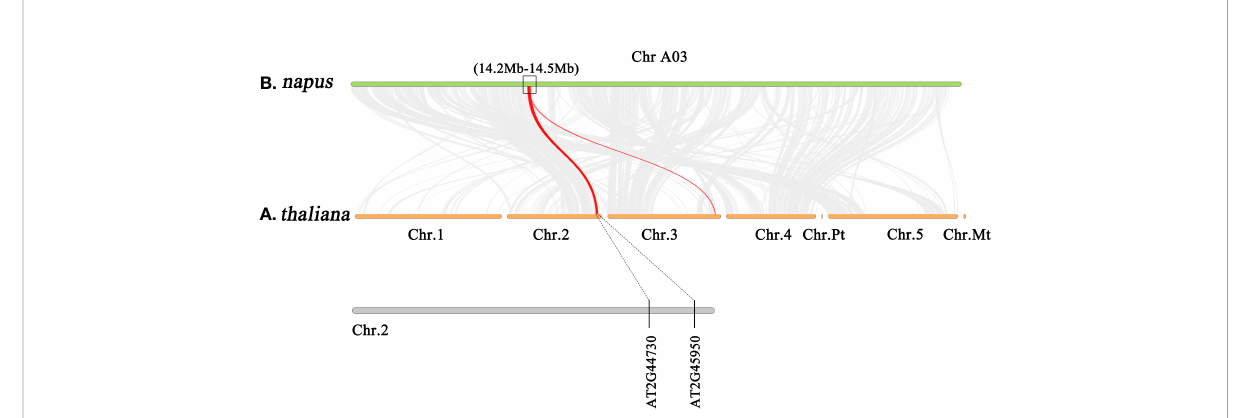
FIGURE 3 Gene synteny analysis between A03 chromosome of B . napus and all chromosomes of A . thaliana